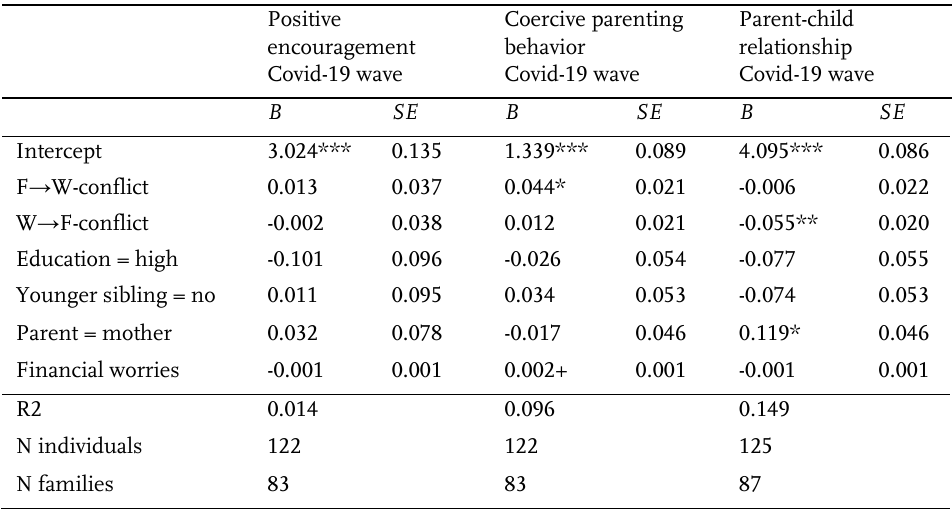
Table A.3b: Multilevel regression models on perceived parenting among mothers and fathers during the Covid-19 wave, while controlling for financial worries. Positive Coercive parenting Parent-child encouragement behavior relationship Covid-19 wave Covid-19 wave Covid-19 wave